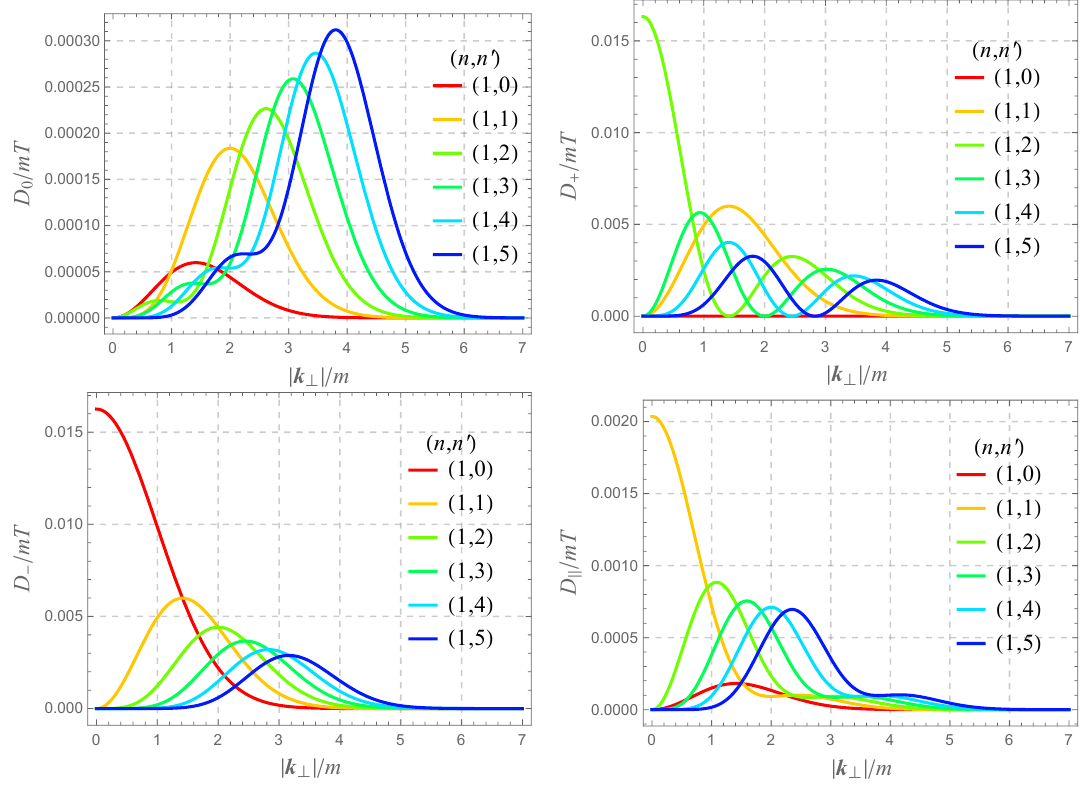
. The Figure 5 . Photon transverse momentum | k ⊥ | -dependences of the conversion rates D n,n 0 λ Landau level of the fermion is fixed at n = 1 , while that of the anti-fermion runs on n 0 = 0 , 1 , 2 , 3 , 4 , 5 . Other parameters are fixed at | qB | /m 2 = 1 , k = 10 , and k = 0 . 0 /m z /m the magnetic field is strong (e.g., the red line in the bottom right panel for k /m = 3 and 0 fall off in a large | k | qB | /m 2 = 3 ). Note that the conversion rates D | /m , and they fall λ ⊥ off slower for larger k . This is because larger k can excite higher Landau levels having 0 0 large | ∆ n | , which are favorably produced with a large | k | because of the reminiscent of ⊥ the transverse momentum